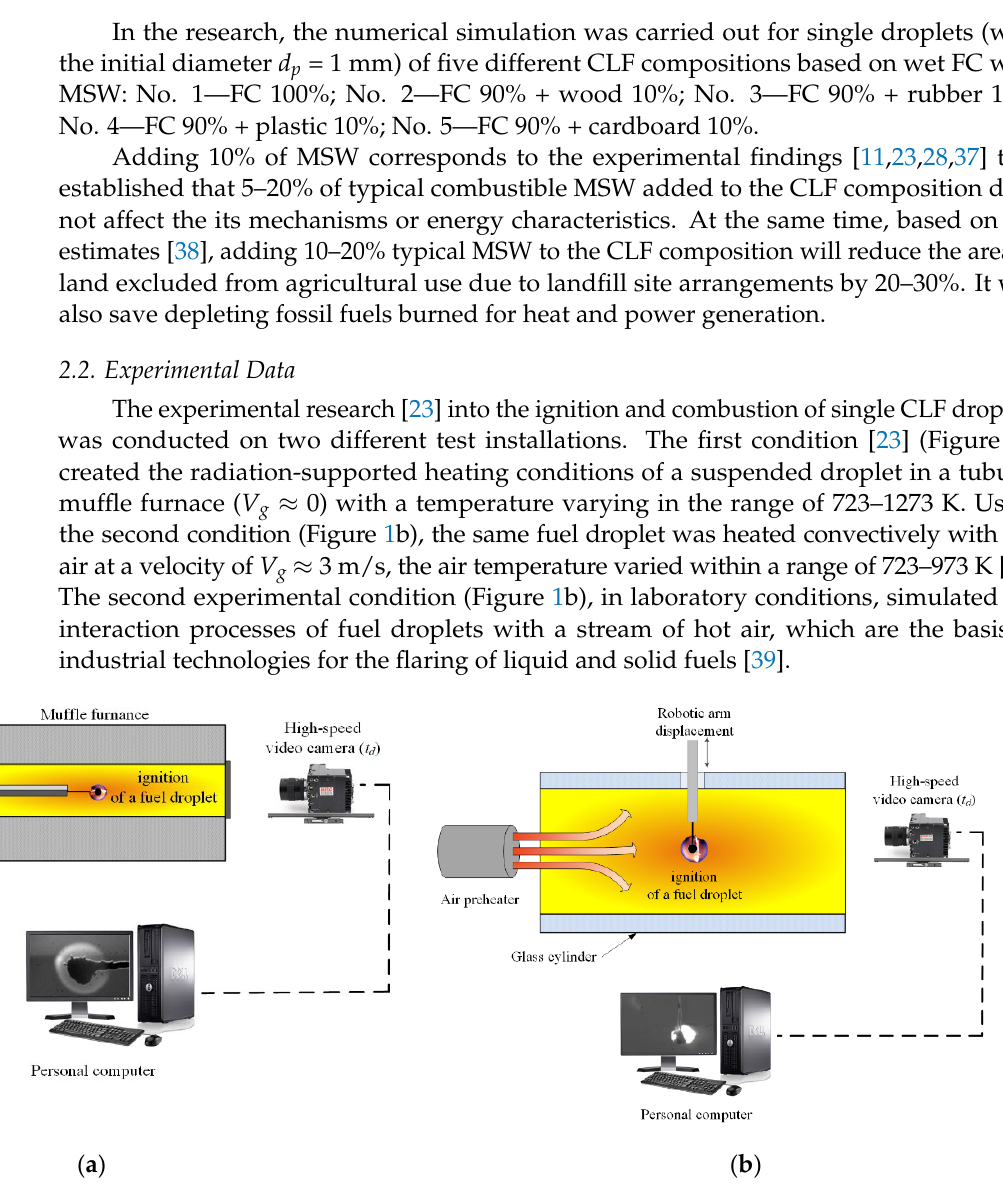
Figure 1. Schematic of experimental conditions: ( a ) first condition; ( b ) second